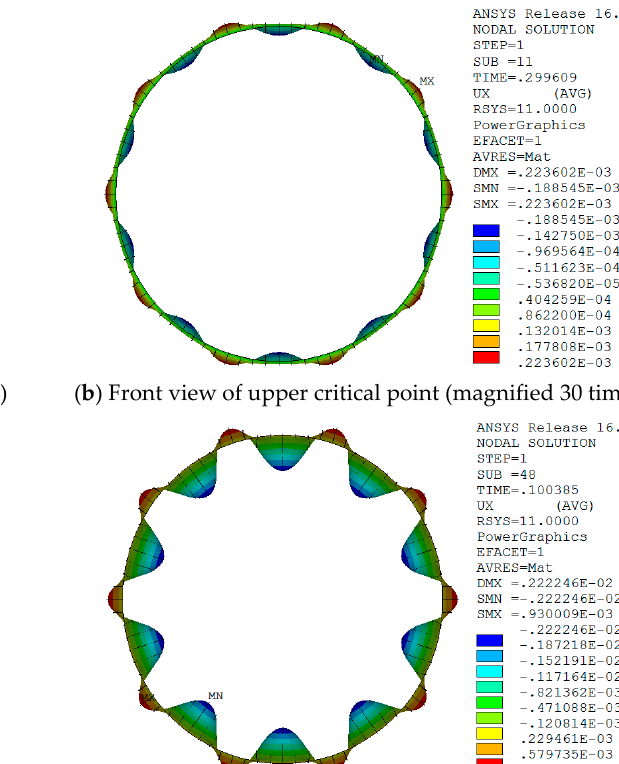
Figure 17. Radial displacement contour map at the critical points of the post-buckling path for the model with the SS3 boundary condition when the material of the model is brass and ξ = 0.1.